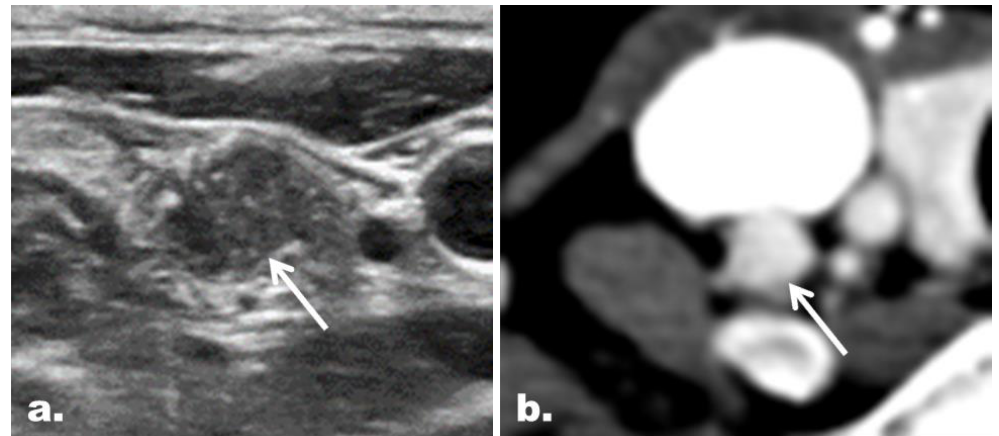
Figure 3. Representative case of a concordant suspicious LN with the final diagnosis of metastasis in a 41-year-old woman with PTC. ( a ) The gray scale US image depicts a round LN (arrow) with microcalcifications at the right neck level IV. The LN was classified as a suspicious LN on US. ( b ) The LN (arrow) showed diffuse strong enhancement on CT and thus was also classified as a suspicious LN on CT.